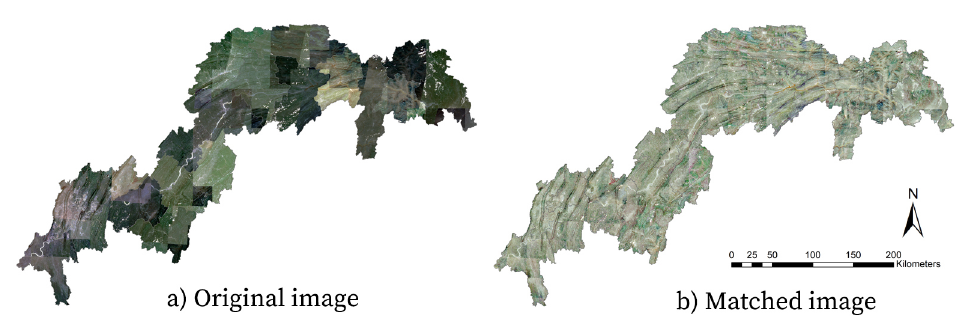
Figure 4. The flow chat of the data preprocessing.